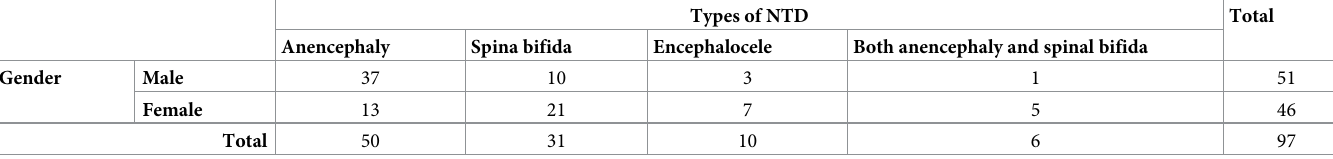
Table 1. Types of NTDs and Genders at Debre Berhan Referral Hospital, North Shewa, Ethiopia, 2019. [N = 97].